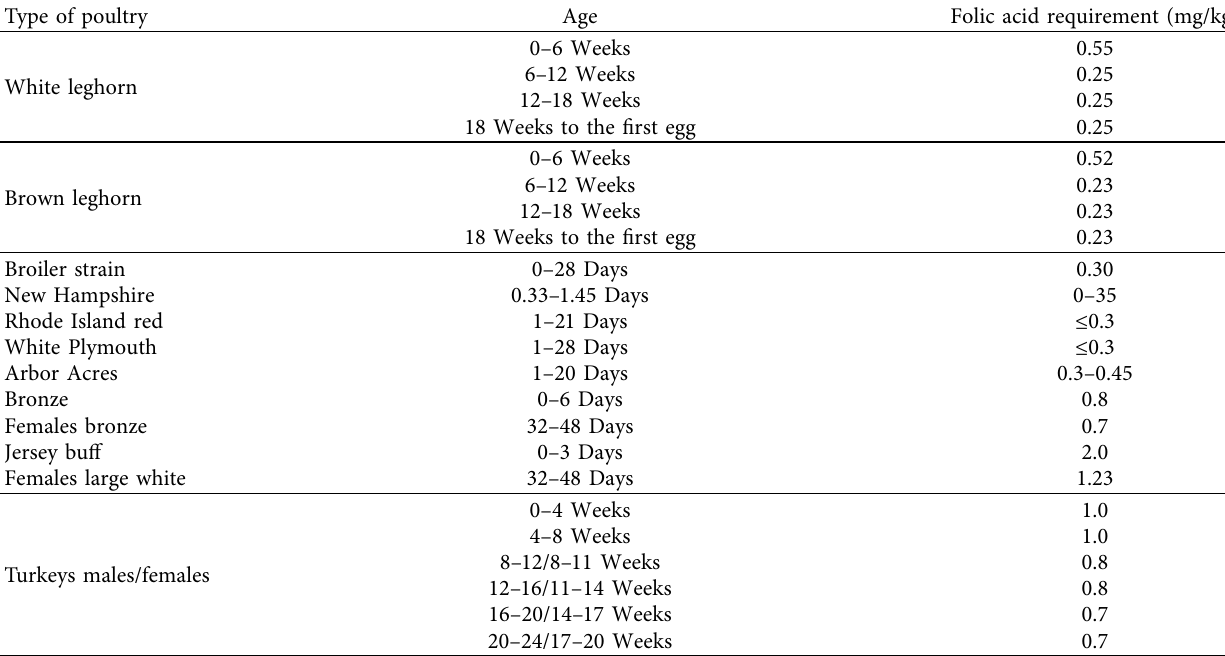
Table 1: NRC recommended levels of folic acid in different poultry